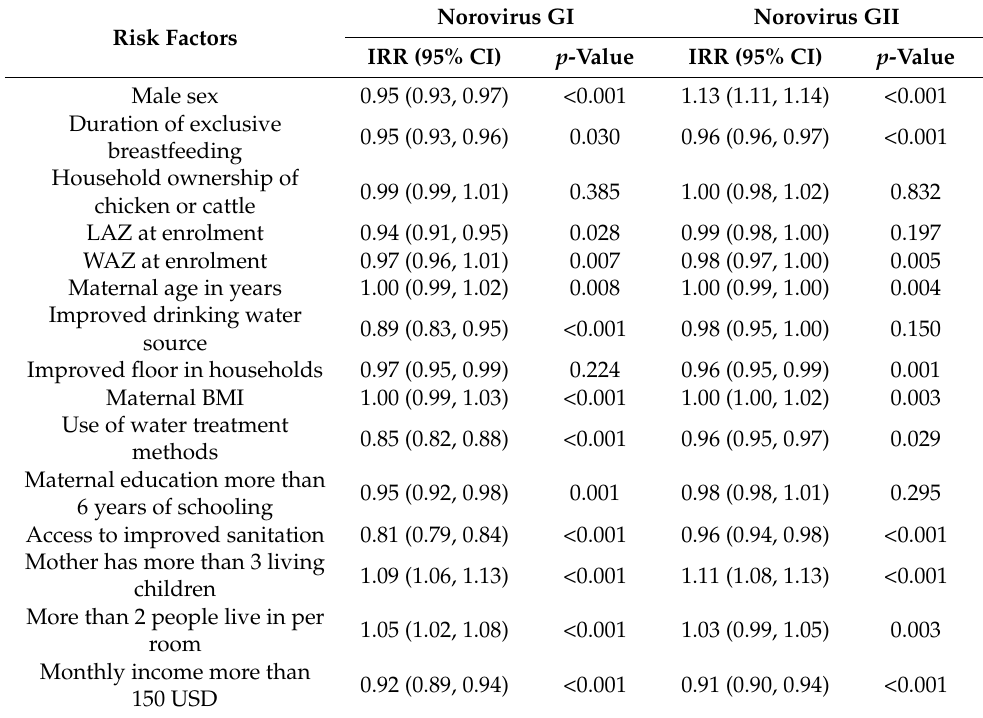
Table 2. Factors associated with detection of norovirus GI and norovirus GII in monthly stool samples across each of the eight study sites during the study